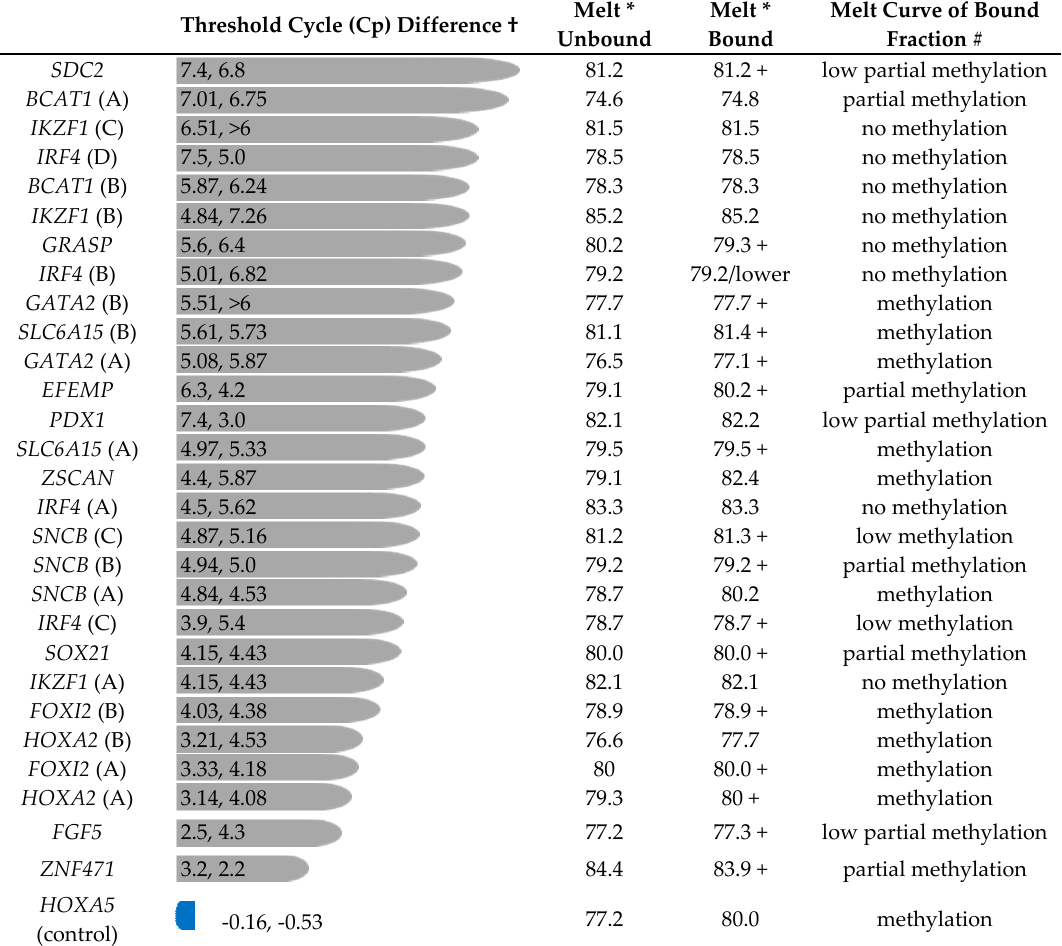
Table 1. Amplification from MethylMiner captured and unbound